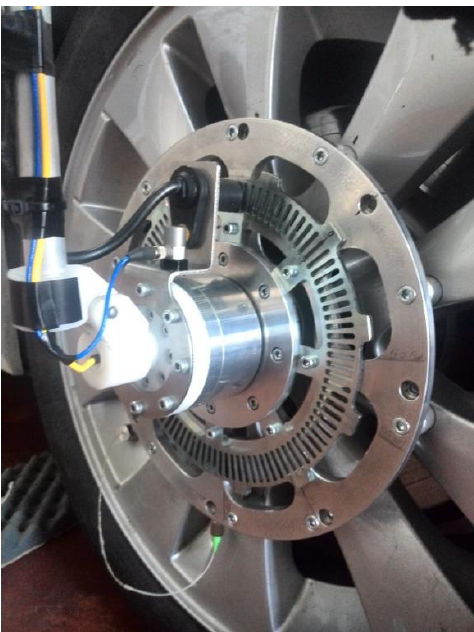
Figure 4. Wheel sensor device onboard with the piezo accelerometers and the wheel encoder.